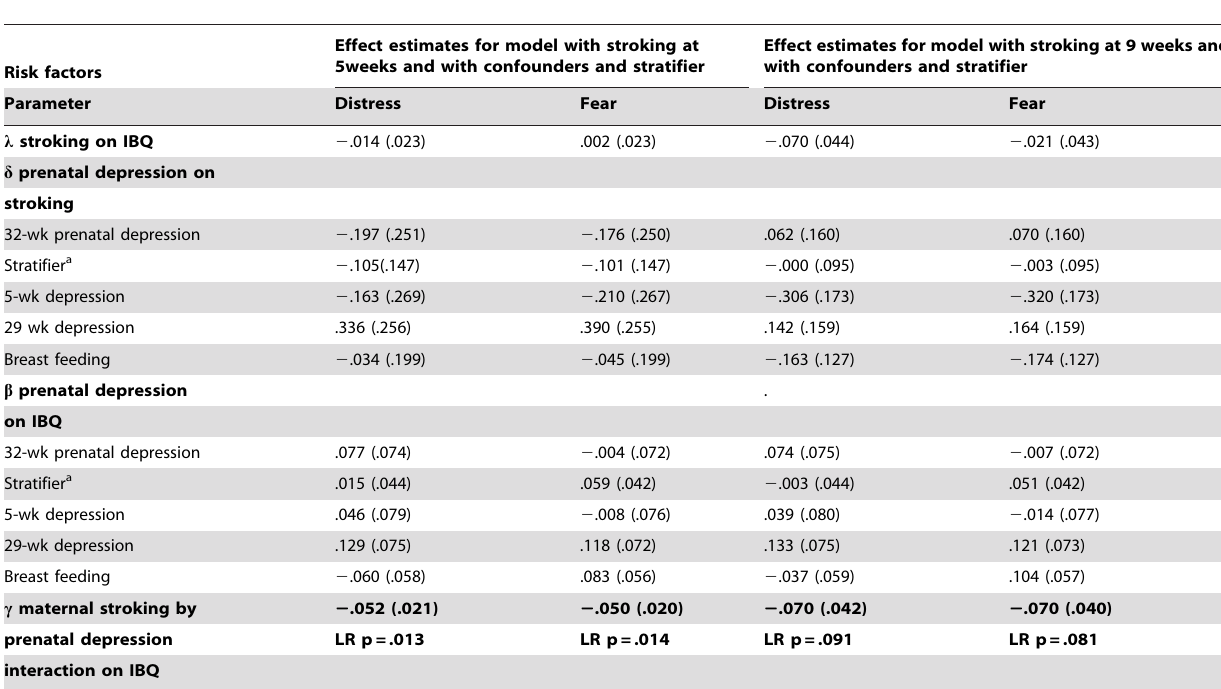
Table 4. Parameter Estimates and Standard Errors for the IBQ Distress to Limitations and IBQ Fear model of Figure S3 (which shows the stroking factor loadings) for the effects of stroking with adjustment for stratification and confounders.